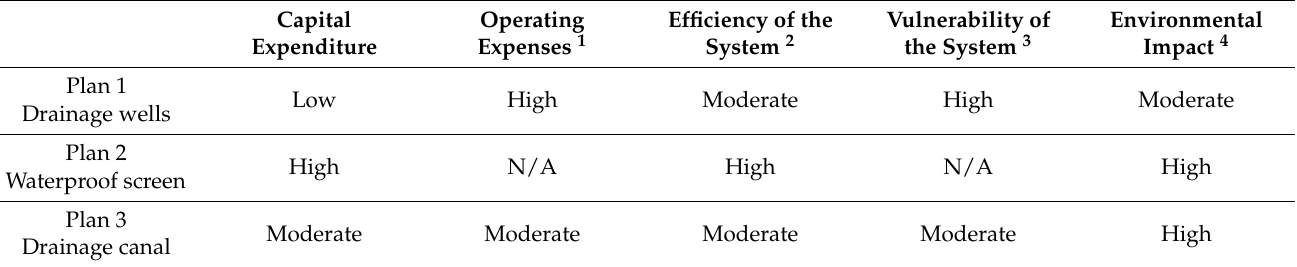
Table 3. Advantages and shortfalls of the management